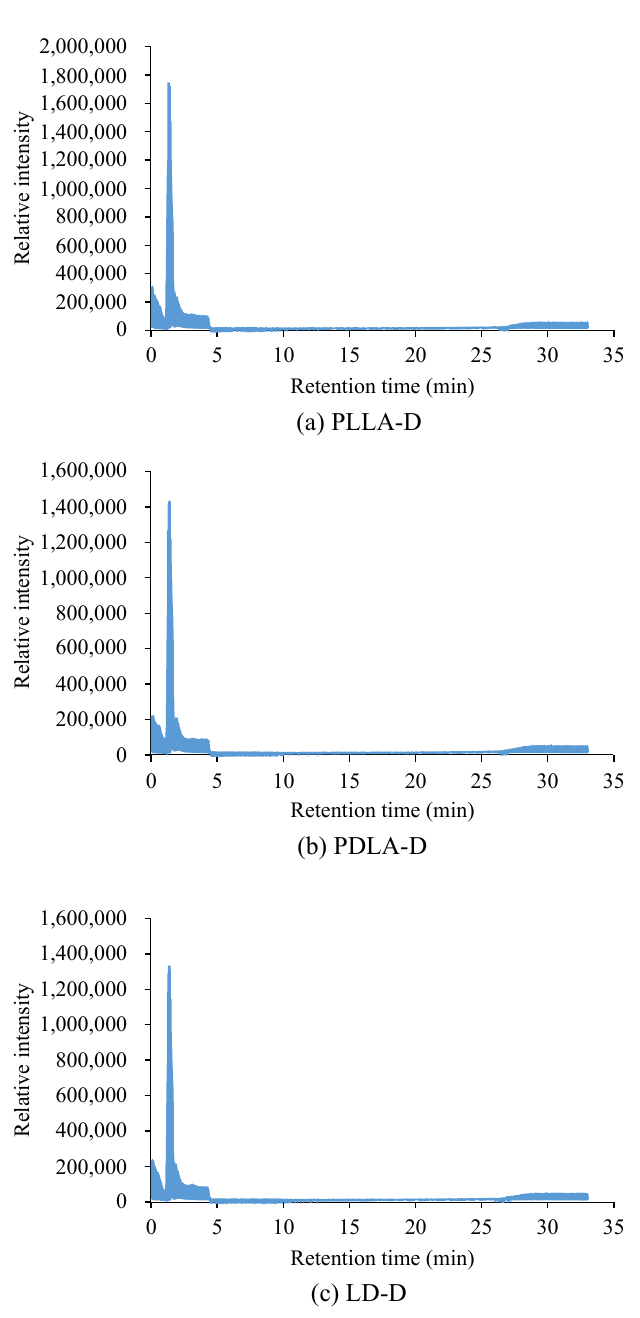
Figure 2. GC–MS chromatogram of ( a ) PLLA-D, ( b ) PDLA-D, and ( c ) LD-D pyrolyzed for 0.5 s at 180 °C. The melting behaviors of PLLA, PDLA, and LD are illustrated in Figure 6. The first heating curves of PLLA-V and PDLA-V revealed melting behaviors almost identical to those of PLLA-R and PDLA-R. These heating curves had a melting peak at 175–177 ◦ C; these peaks were caused by the melting of homocrystals [27]. The corresponding cooling and reheating curves of PLLA and PDLA at 10 ◦ C/min after melting at 200 ◦ C for 3 min are shown in Figure 7. PLLA-V and PDLA-V exhibited homocrystallization behaviors almost identical to those of PLLA-R and PDLA-R during cooling (Figure 7a). They demonstrated cold crystallization peaks followed by melting peaks at 173–175 ◦ C during reheating owing to the melting of homocrystals. The melting enthalpy values in the reheating curves of PLLA-V and PDLA-V were 51.3 and 52.5 J/g, respectively (Figure 7b). These values were slightly higher than the corresponding values for PLLA-R and PDLA-R, which were